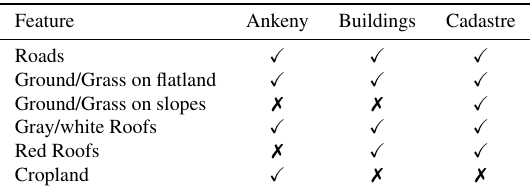
Table 3. Point cloud dataset content break down. The datasets are heterogeneous and contain different objects and types of terrain.